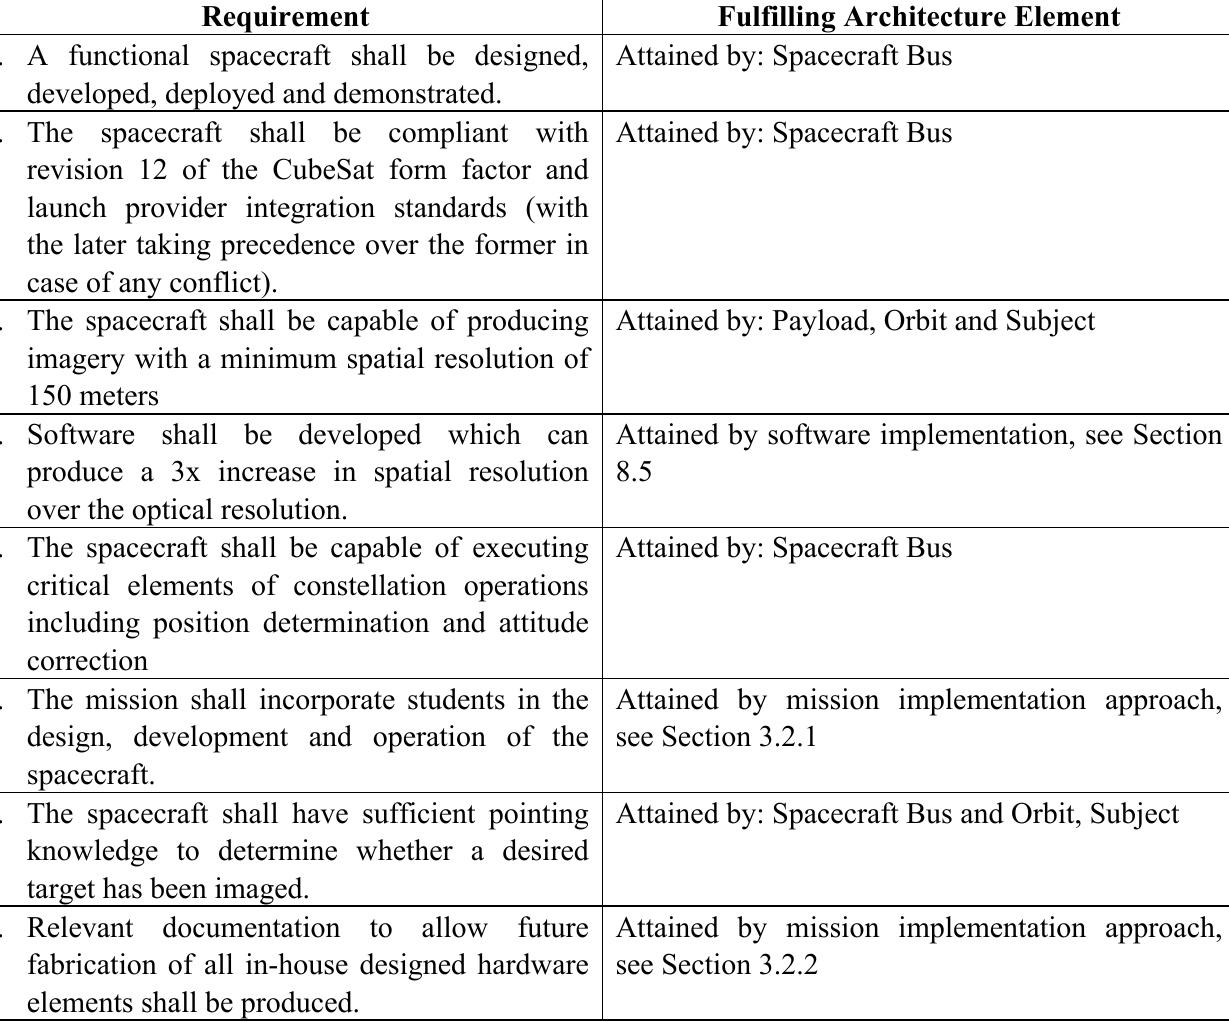
Table 4. Implementation of Requirements by Mission